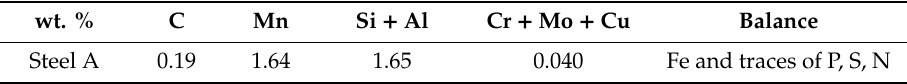
Table 1. Elemental composition in weight percentage of the industrial reference steel. wt. % C Mn Si + Al Cr + Mo + Cu Balance